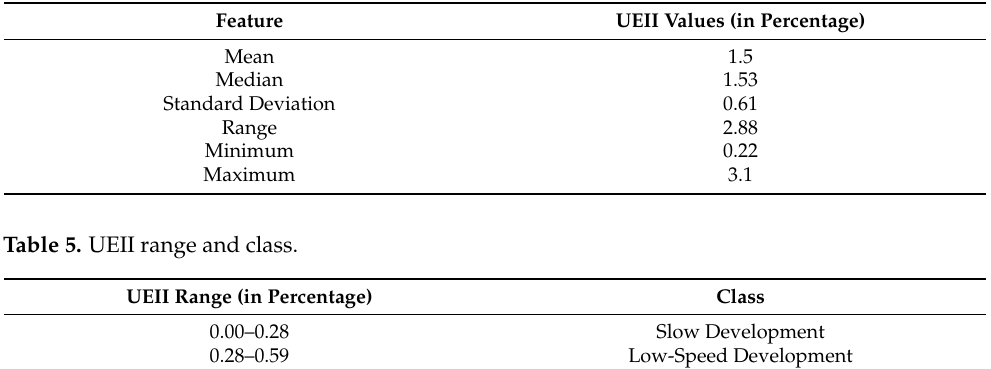
Table 4. Descriptive statistics of UEII for 1992–2019 for 49 U.S. cities.